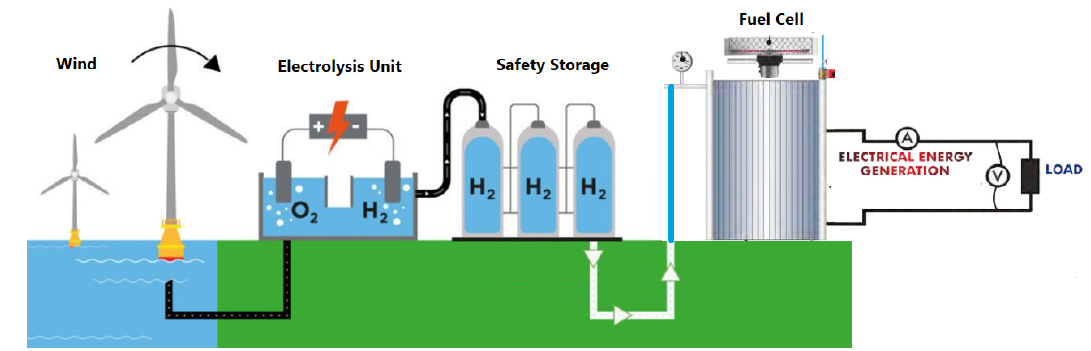
Figure 19. Wind/H 2 system for hydrogen and electricity production.